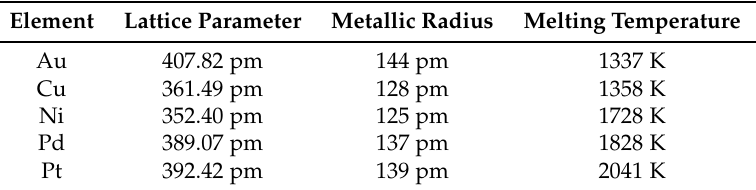
Table 1. Lattice parameter of the respective fcc structure [18], metallic radius [19] and melting temperature [18] of gold, copper, nickel, palladium and